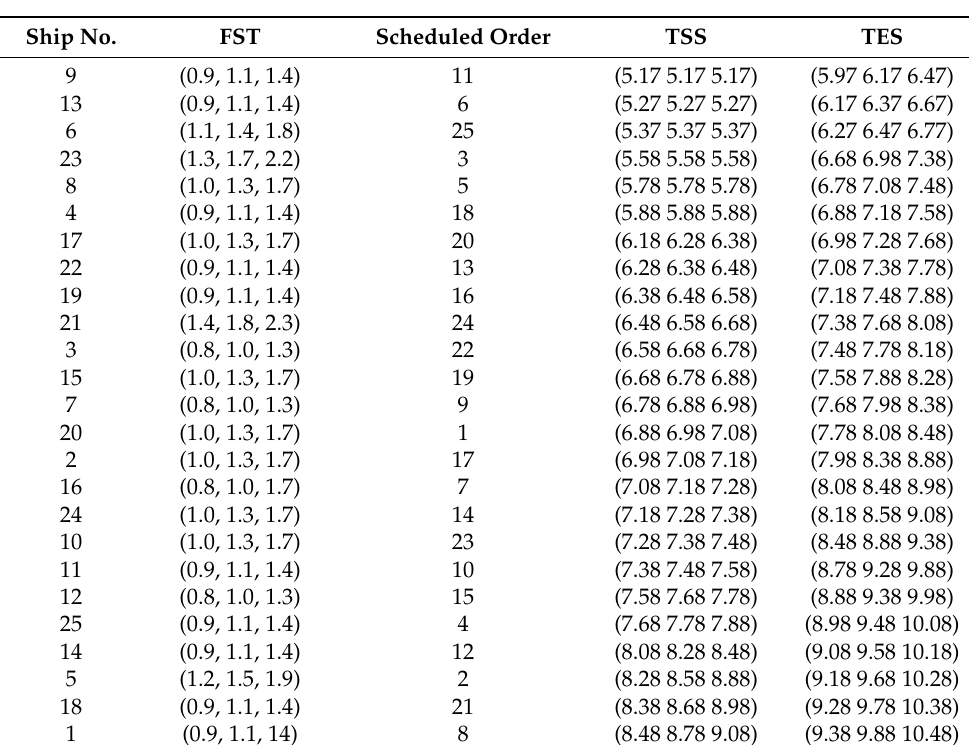
Table 6. Fuzzy vessel scheduling results (Case_25_1). Ship